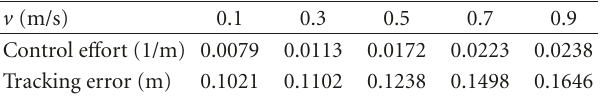
Table 2: Influence of speed for corridor following. v (m/s) 0.1 0.3 0.5 0.7